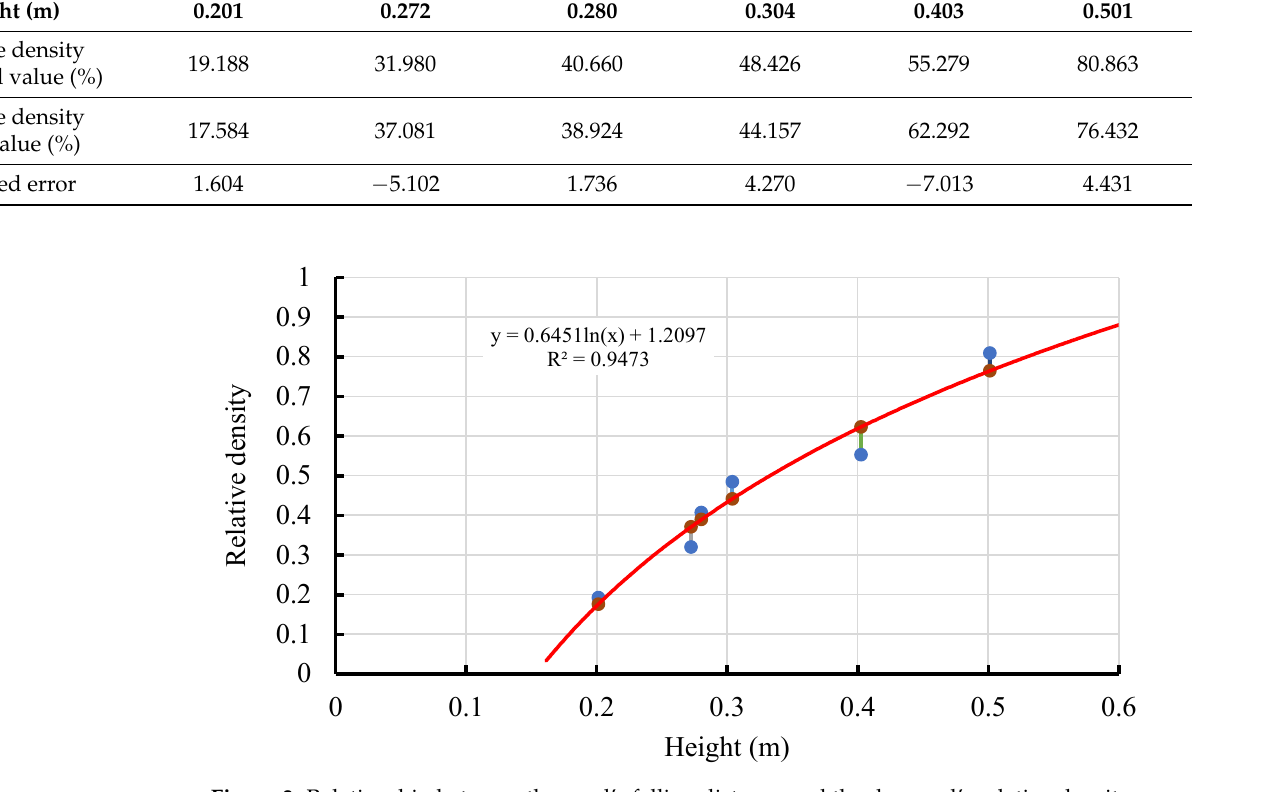
Figure 3. Relationship between the sand’s falling distance and the dry sand’s relative density.